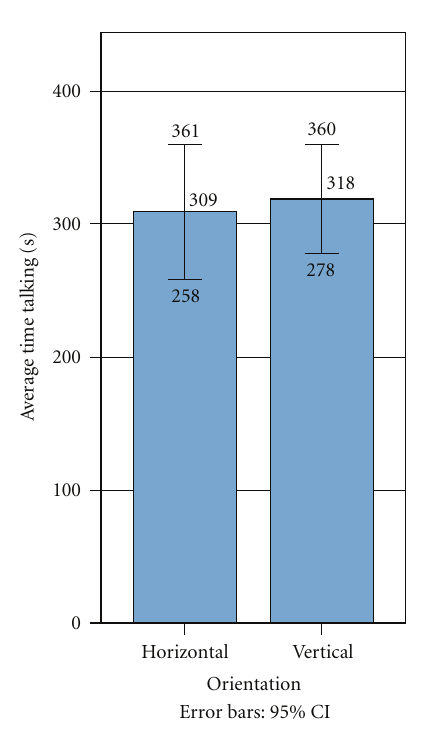
Figure 6: Average time talking per minute (per